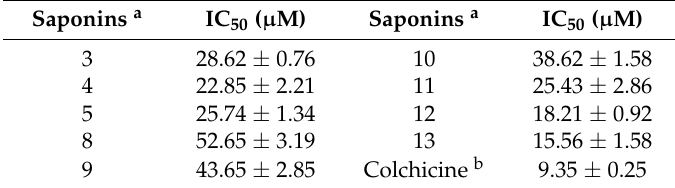
Table 3. Anti-proliferation activity of saponins 1 – 13 on HSC-T6 cells (mean ± SD, n = 3).